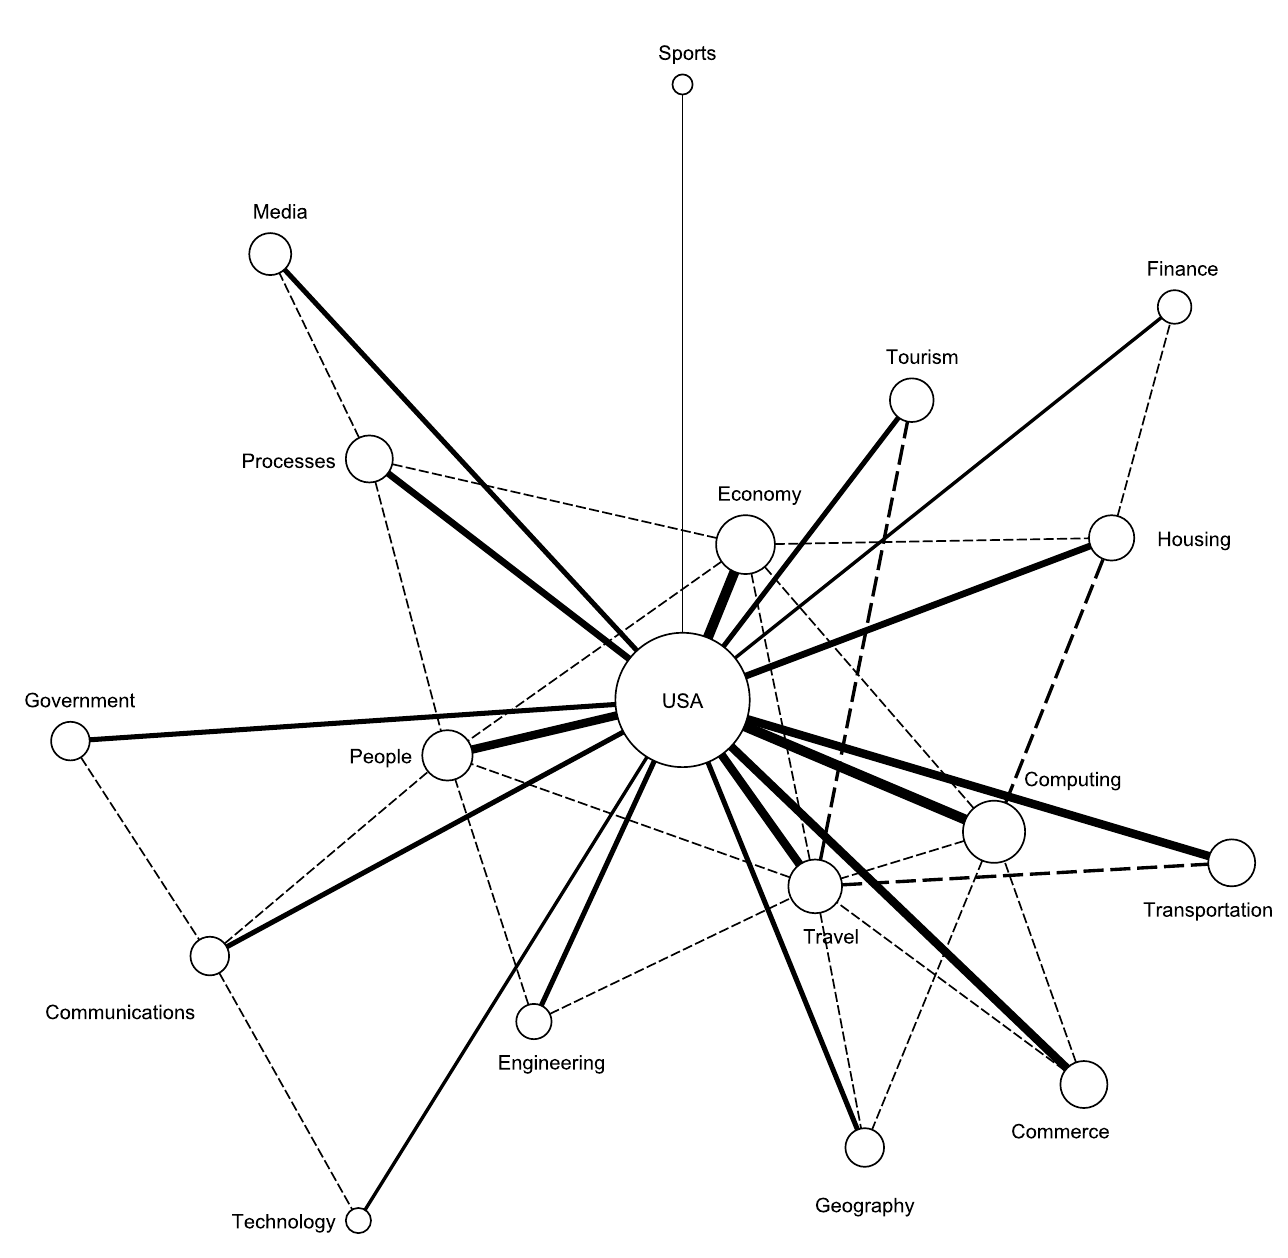
Figure 6. Semantic network generated for the United States Smart City